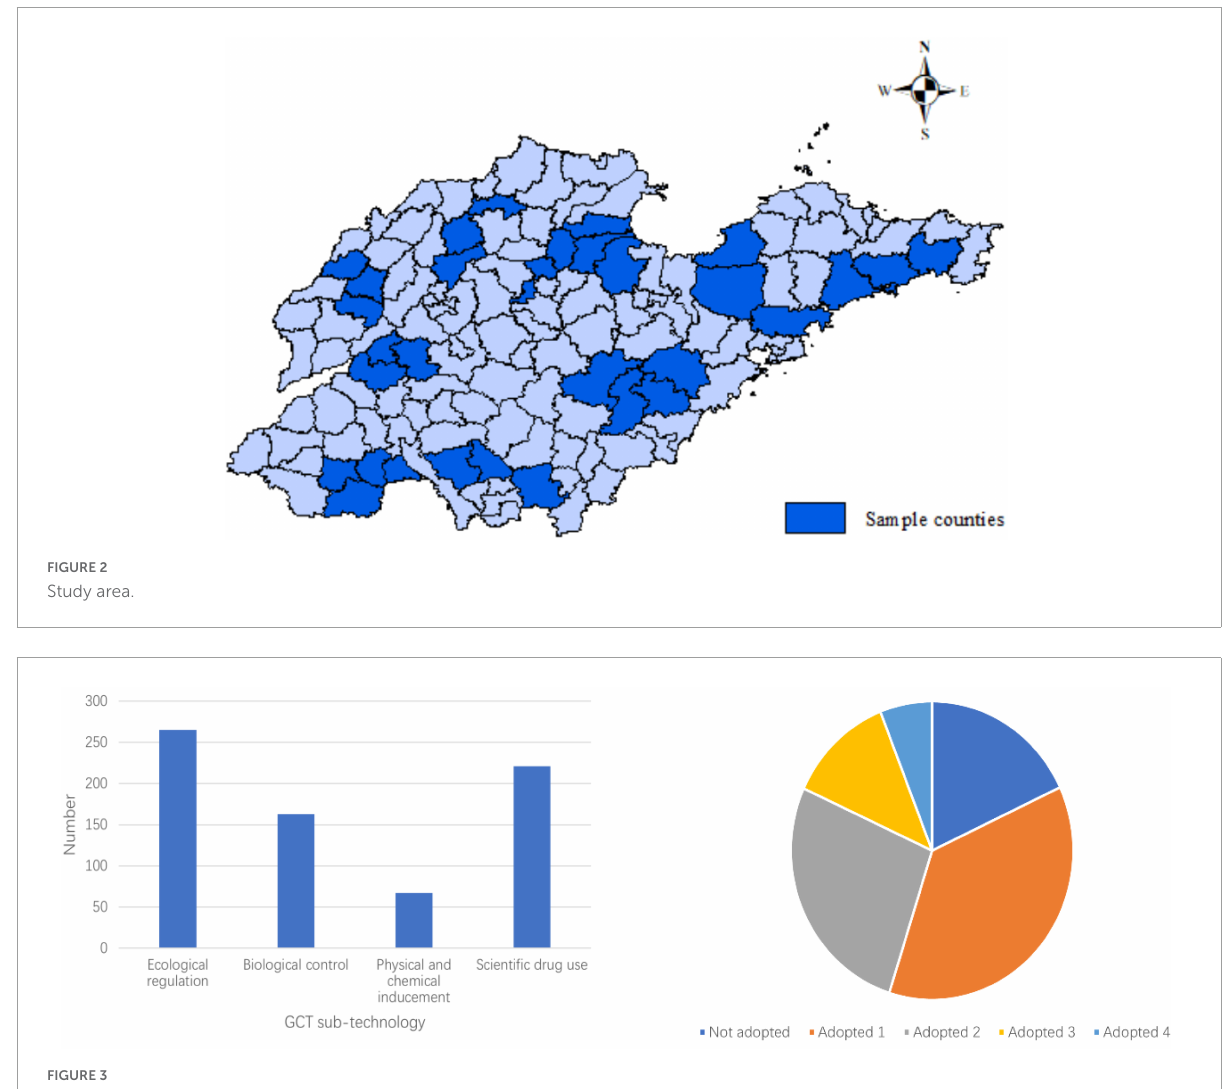
FIGURE3 Adoption of farmers’ green control technology (GCT)